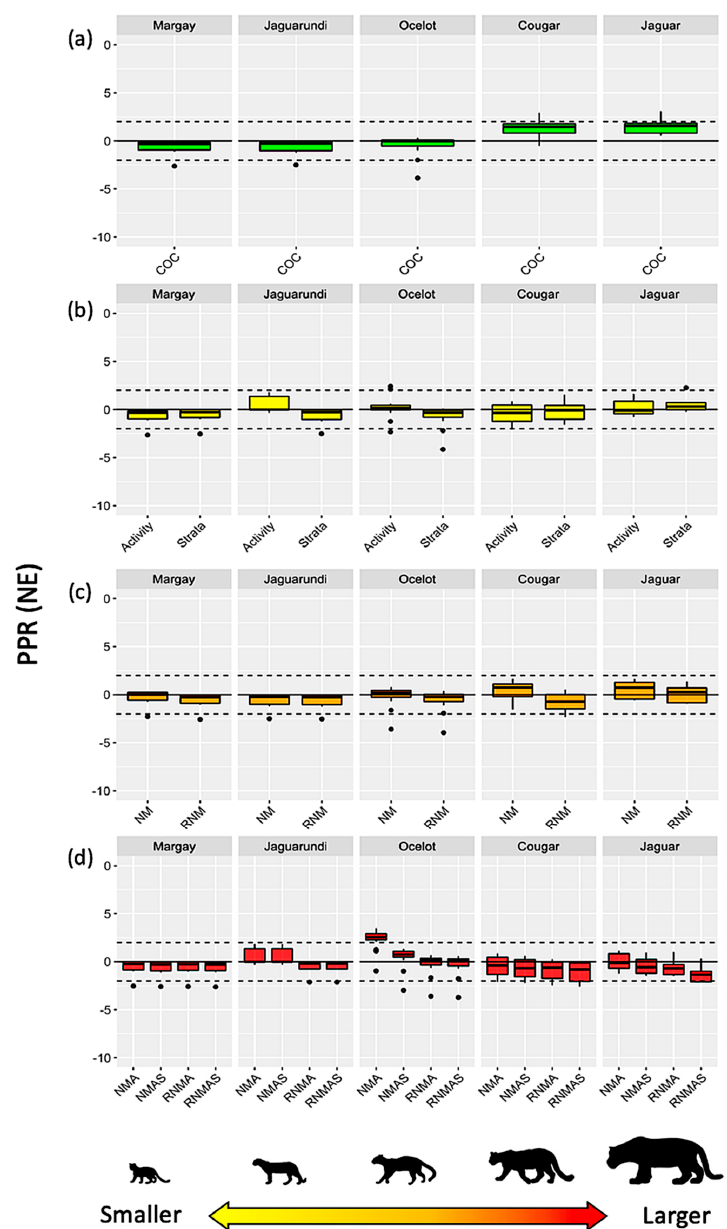
Figure 3. Normalized error (NE) of the predator–prey ratio for the nine models evaluated at the locality level for each predator species, where the x -axis shows the different predator species and models and the y -axis shows the normalized errors for ( a ) co-occurrence model, ( b ) Spatiotemporal models, ( c ) body size models and ( d ) saturated models. The upper horizontal dashed line indicates the reference value plus two standard deviations, while the lower horizontal dashed line indicates the reference value minus two standard deviations and the continuous horizontal line indicates the reference value. See Table 1 and the methods for model